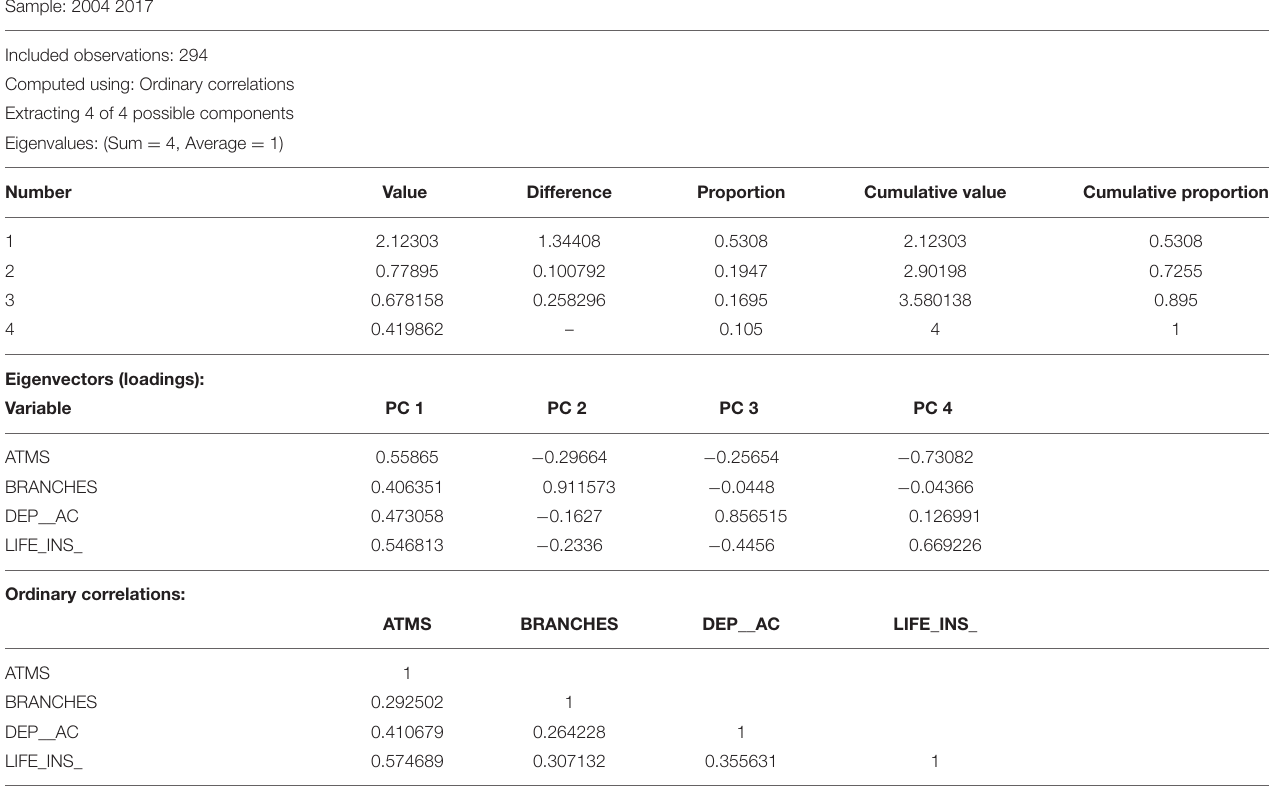
TABLE 2 | Principal component